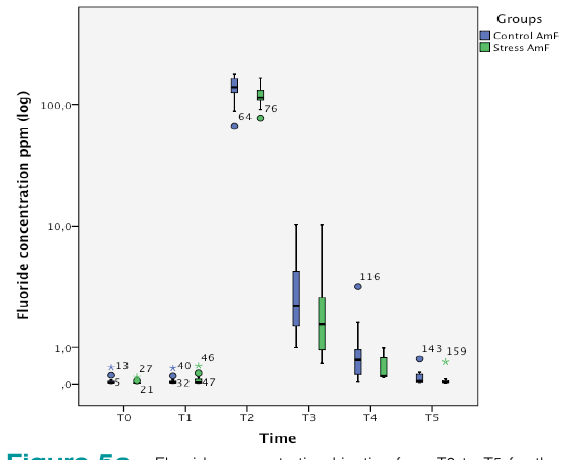
Figure 5a. Fluoride concentration kinetics from T0 to T5 for the AmF control and stress groups (logarithmic scale).